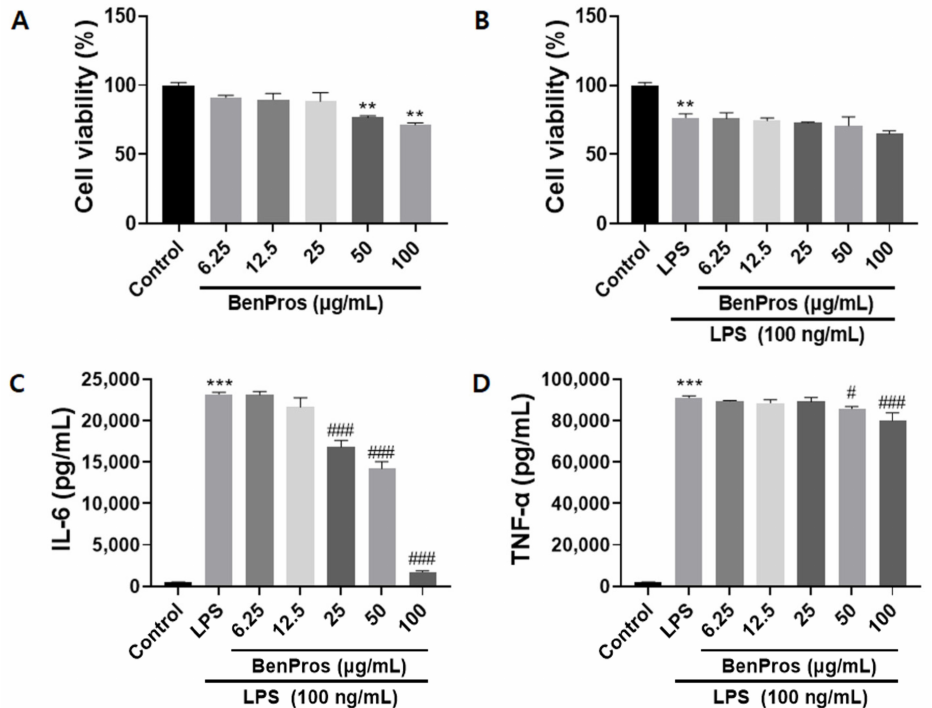
Figure 2. Effect of BenPros on cell viability and anti-inflammatory ability in RAW264.7 macrophages. ( A ) Cell viability of RAW264.7 cells treated with BenPros in the absence of LPS stimulation. ( B ) Cell viability in LPS-stimulated RAW264.7 cells. ( C ) TNF- α production in LPS-stimulated RAW264.7 cells. ( D ) IL-6 production in LPS-stimulated RAW264.7 cell. Cells were pre-treated with various concentrations of BenPros for 30 min and stimulated with LPS (100 ng/mL) for 24 h. Data are presented as means ± standard deviation from three separate experiments. ** p < 0.01 and *** p < 0.001 vs. control; # p < 0.05 and ### p < 0.001 vs.